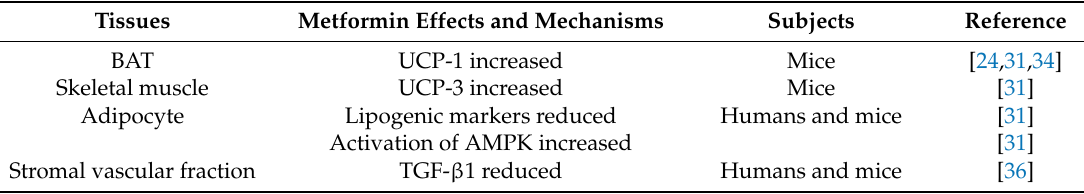
Table 2. Beneficial effects of metformin on energy metabolism and white-adipose-tissue (WAT)